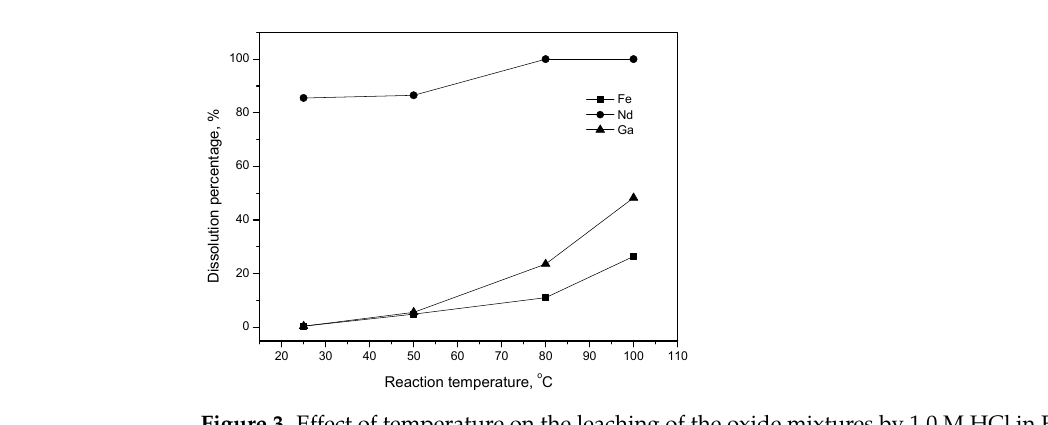
Figure 3. Effect of temperature on the leaching of the oxide mixtures by 1.0 M HCl in EG. Operation conditions: pulp density = 50 g/L, time = 90 min, stirring speed = 400 rpm.